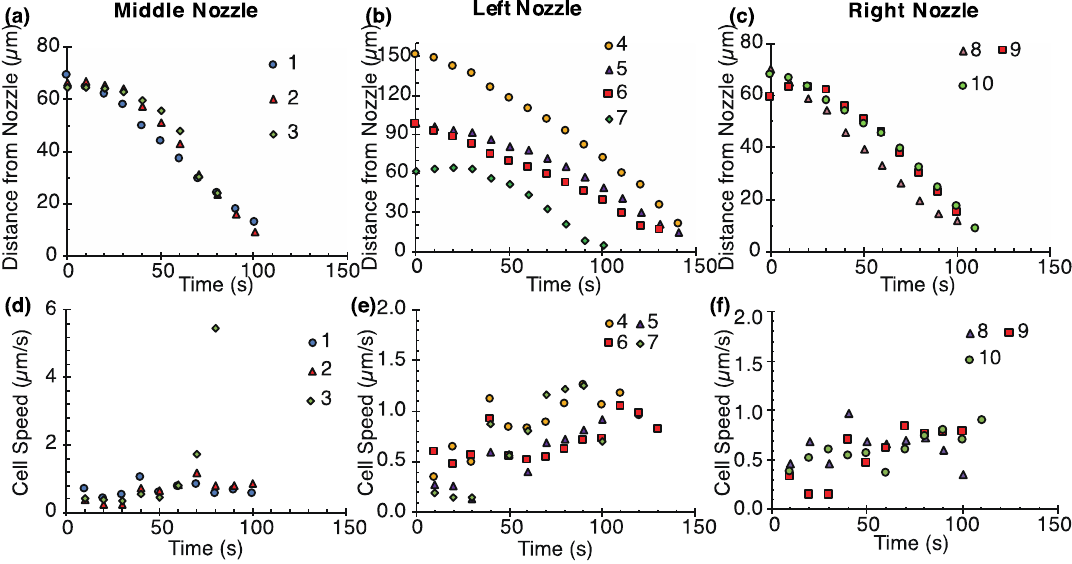
Figure 7. Characterization of parallel single cell suction. ( a – c ) Relationship between the distance of single cells from the nearest nozzle and time. ( d – f ) Relationship between the speed of the cells and